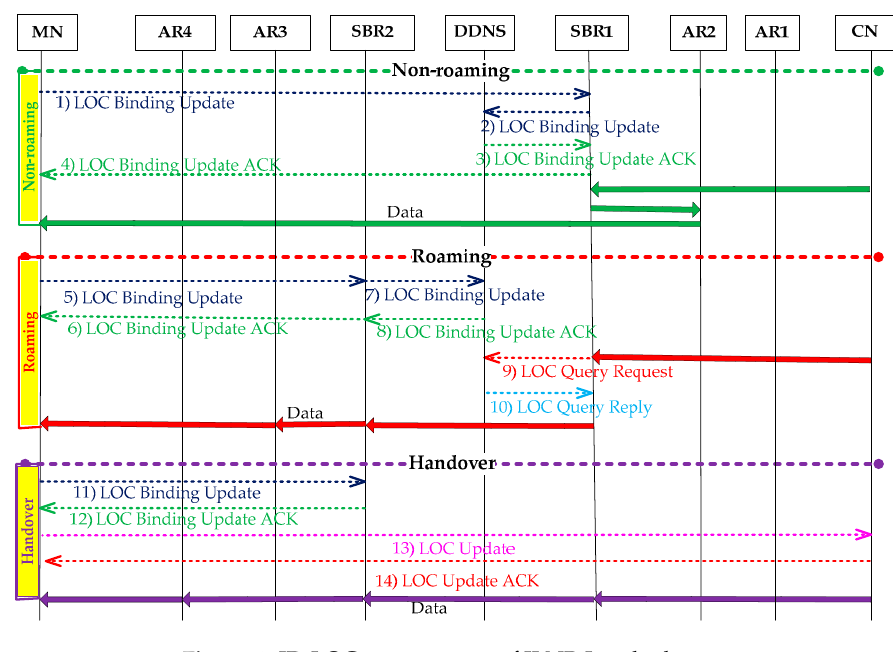
Figure 4. ID-LOC management of ILNP-Local scheme.